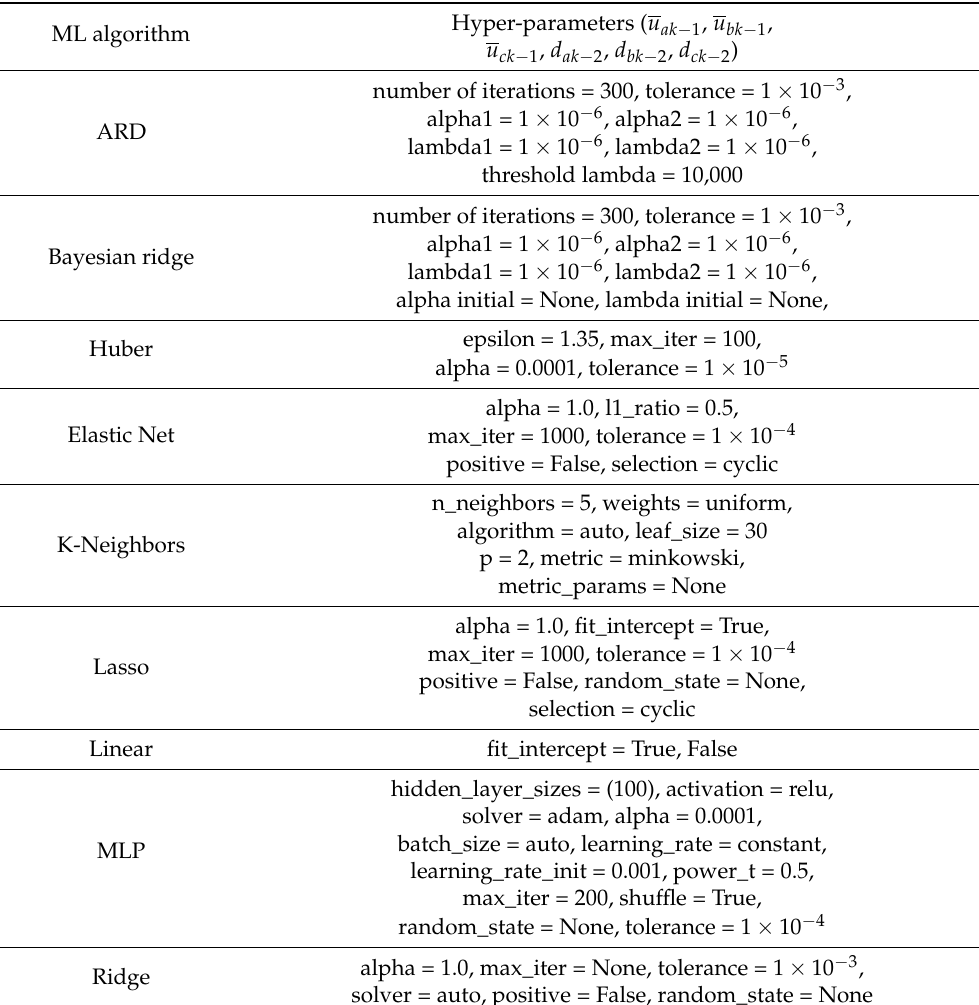
Table 12. Default hyper-parameters of ML algorithms used to obtain the results shown in Figure